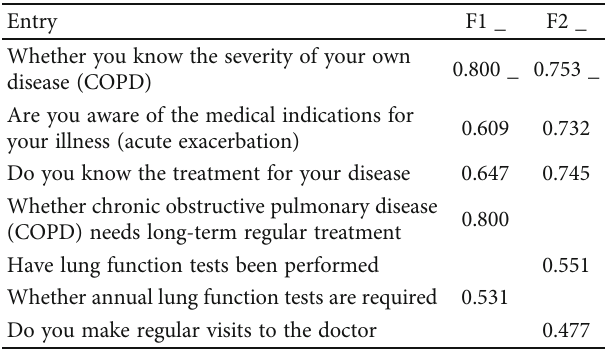
Table 4: Factor analysis of COPD cognitive questionnaire - overall explained